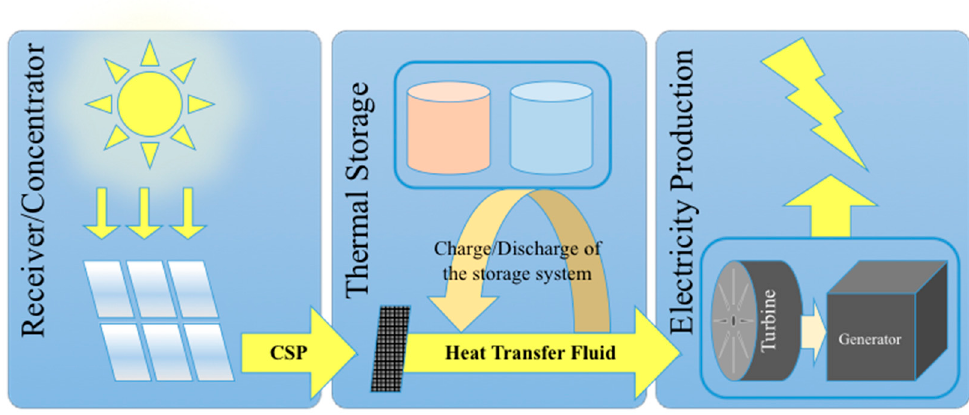
Figure 1. Scheme of the solar power plant main components integrating buffer thermal energy storage system.